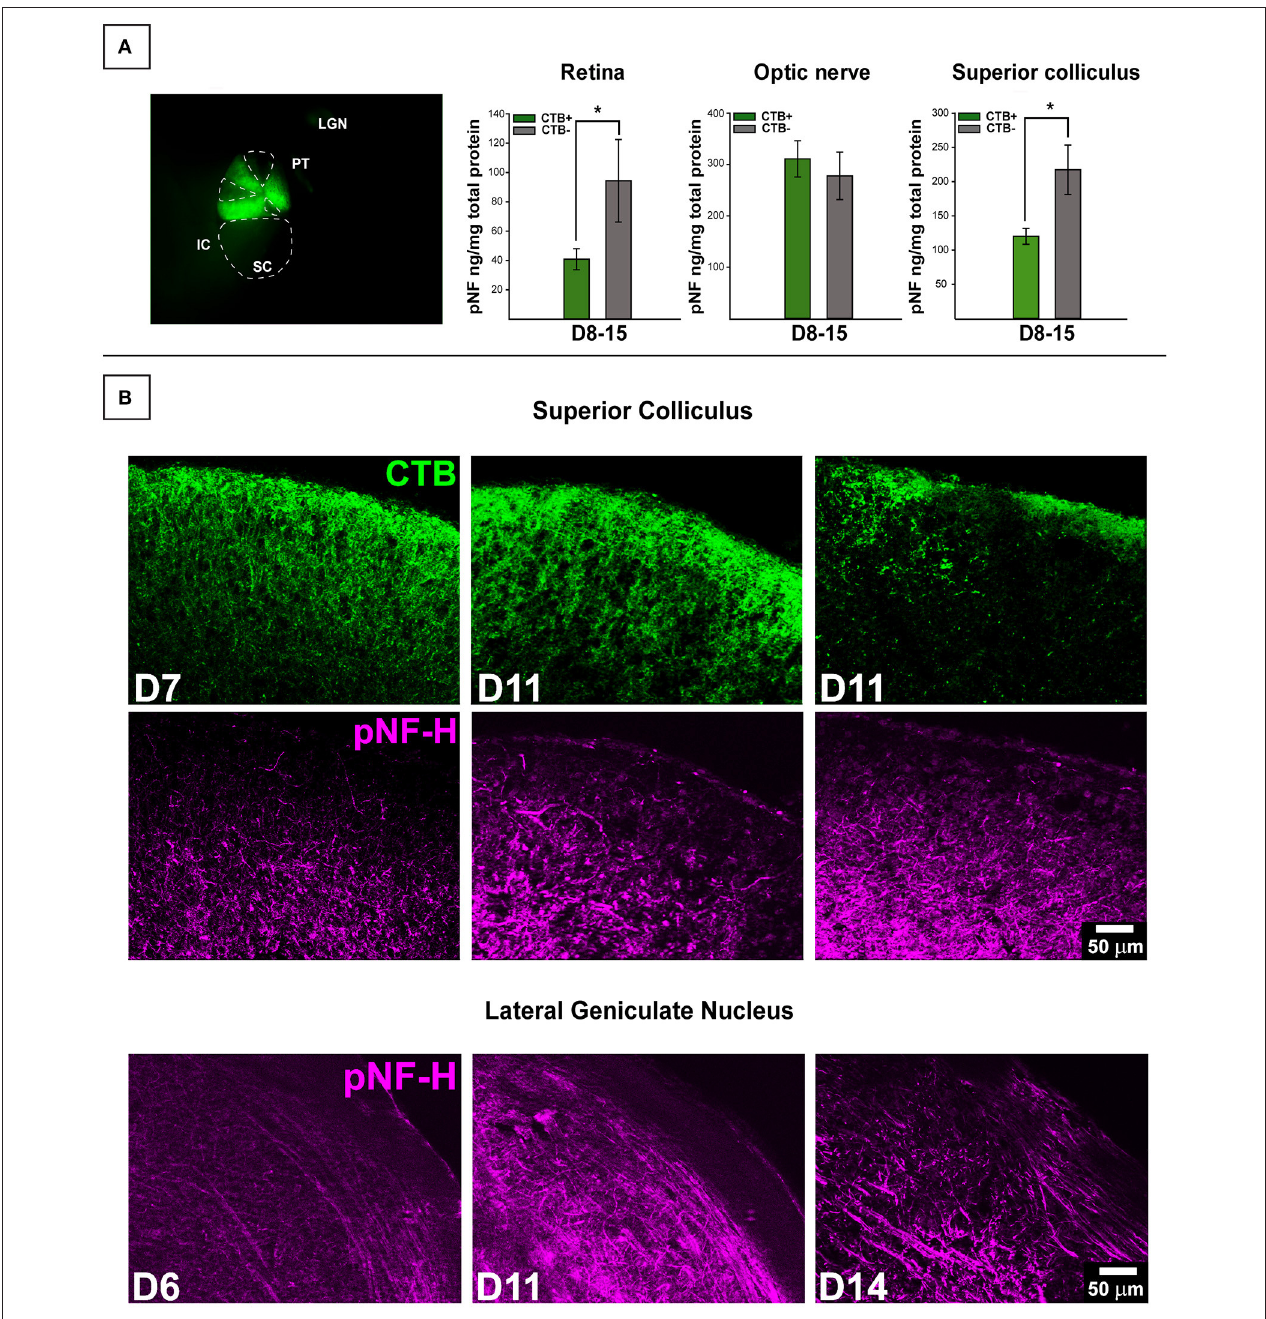
FIGURE 2 | Transport-dependent elevations in pNF-H observed in retina and SC of DBA/2J mice. (A) (Left) Photomicrograph from the dorsal surface of a whole-mount pathological SC in which the cortex has been removed and cholera toxin-B (CTB) labeling shows sectorial loss in the left (top) collicular lobe and complete loss in the right (bottom) lobe. Abbreviations: IC, inferior colliculus; PT, pre-tectum; LGN, lateral geniculate nucleus; SC, superior colliculus. The dotted lines demarcate areas absent of CTB indicating axonal transport deficit (CTB-). (Right) ELISA quantification of pNF-H in retina, optic nerve (ON), and SC. The transport status of retina and ON were determined by whether or not the SC was CTB + ( > 90% CTB-label for partially transporting projections) or CTB- ( < 10% CTB-label for partially transporting projections). Levels of pNF-H were significantly elevated nearly 2-fold in both retina and SC of CTB- projections compared to CTB + projections. Asterisks indicate significant statistical differences ( p < 0.05). Error bars depict SEM. (B) Top panel shows immunofluorescence of the SC, comparing 7-months. (D7), and 11-months. (D11) DBA/2J with and without CTB transport. Visibly increased pNF-H is shown in CTB- D11 SC. Bottom panel illustrates an age-dependent increase in pNF-H staining in the LGN (the visual thalamus) of 6, 11, and 14-month DBA/2J mice.